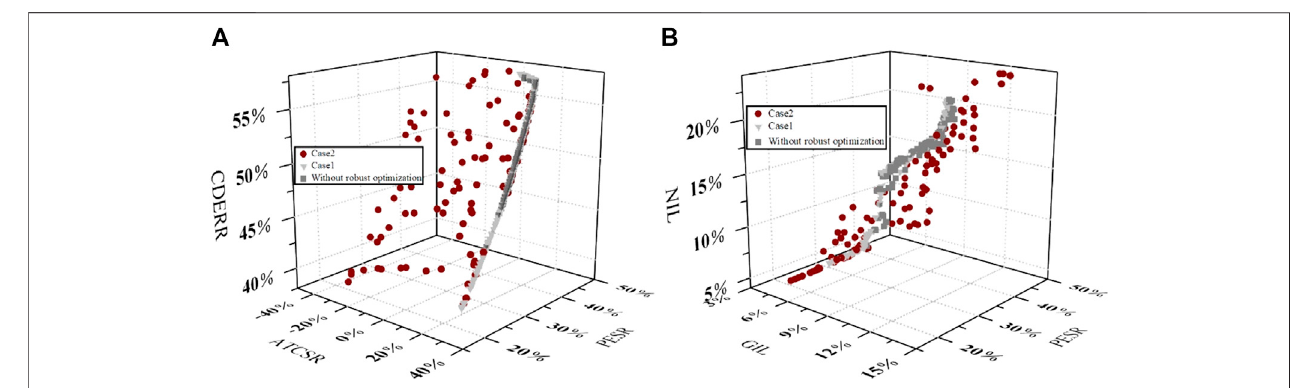
Frontiers in Energy Research |